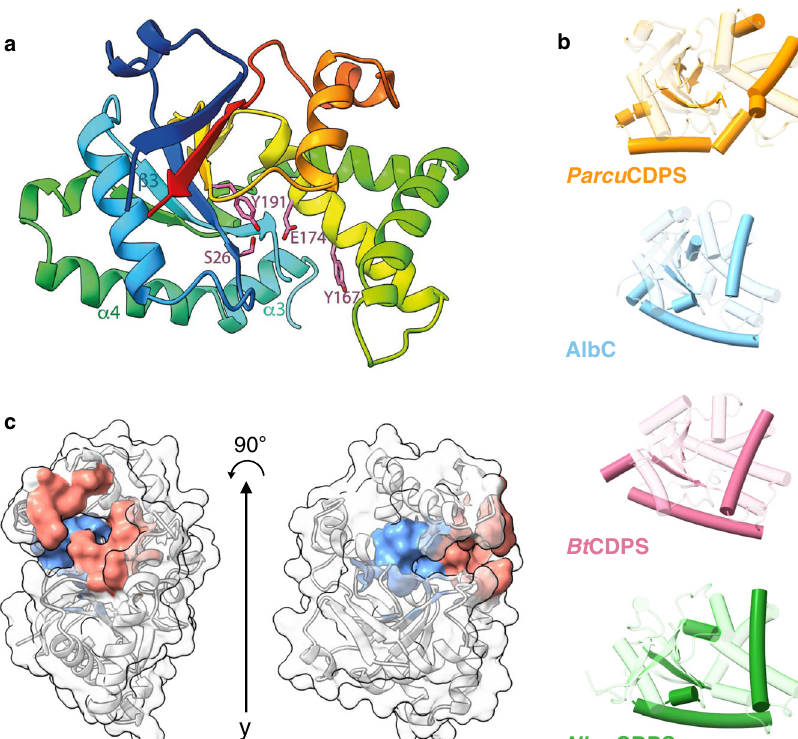
Fig. 4 Structure of Parcu CDPS. a Structure of Parcu CDPS coloured rainbow (blue N terminus to red C terminus) and active site residues (pink). b Secondary structure comparison of Parcu CDPS to three other CDPSs: AlbC, BtCDPS and Nbra CDPS. The common CDPS core is shown as transparent colour whilst the major differences are 100% opaque. c Pocket volumes of both P1 (blue) and P2 (red) in Parcu CDPS are displayed here as calculated by CASTp 38